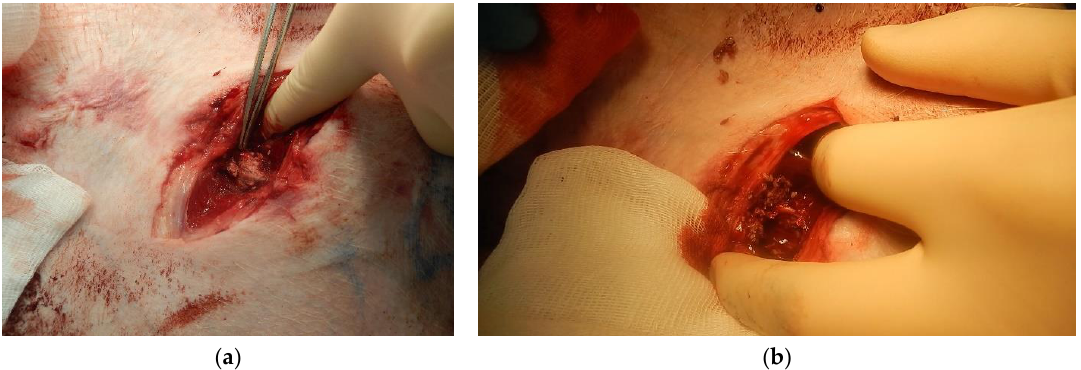
Figure 8. The results of using «Chitosan aerogel» on a model of arterial bleeding: ( a ) after applying the chitosan aerogel; ( b ) after chitosan aerogel removal When using the «Chitosan aerogel», primary hemostasis was achieved in both experiments.